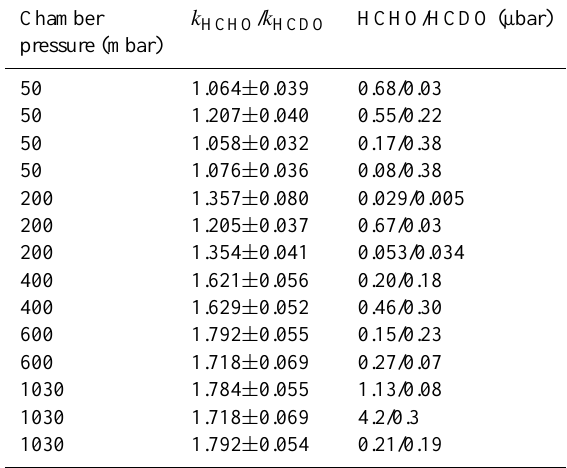
Table 2. Summary of experimental results at different cham- ber pressures. The second column presents the isotope effect k HCHO / k HCDO obtained from the relative rate plots. The last col- umn gives the initial partial pressures of the two isotopologues in each experiment. Chamber k HCHO / k